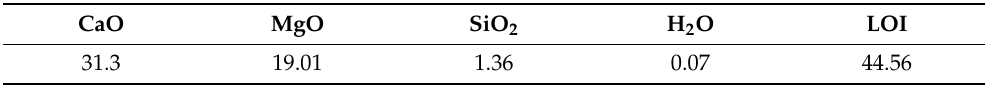
Figure 1. The XRD analysis of LCM. Table 2. Chemical compositions of dolomite (mass, %).